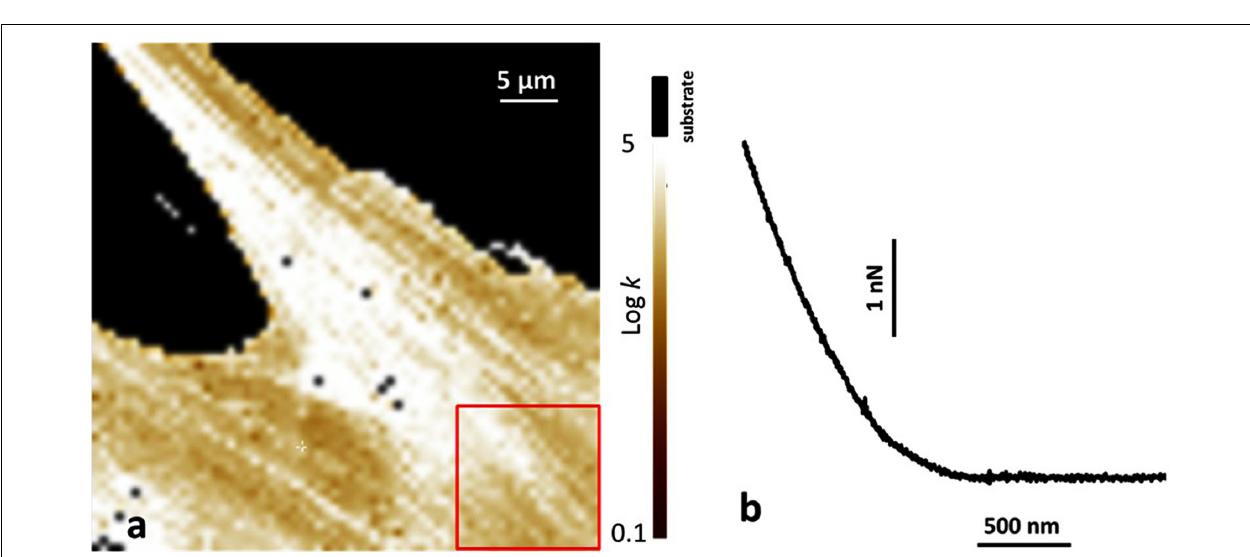
FIGURE 3 | Atomic force microscopy (AFM) analysis of human bone marrow-derived mesenchymal stem cells (hBMSCs) grown on a plastic Petri dish and on Coll/Pro Osteon R (cid:13) 200 biomaterial. (a) Map of the Young modulus of hBMSCs grown on a plastic Petri vessel. The value of the Young modulus is reported with a Log scale. The substrate is identified by the black region, as also reported on top of the color scale. The red square shows a typical area over which the Young modulus was averaged. (b) Typical example of a force curve obtained on cells on the biomaterial. The horizontal axis reports the tips-sample displacement, and the vertical axis reports the applied